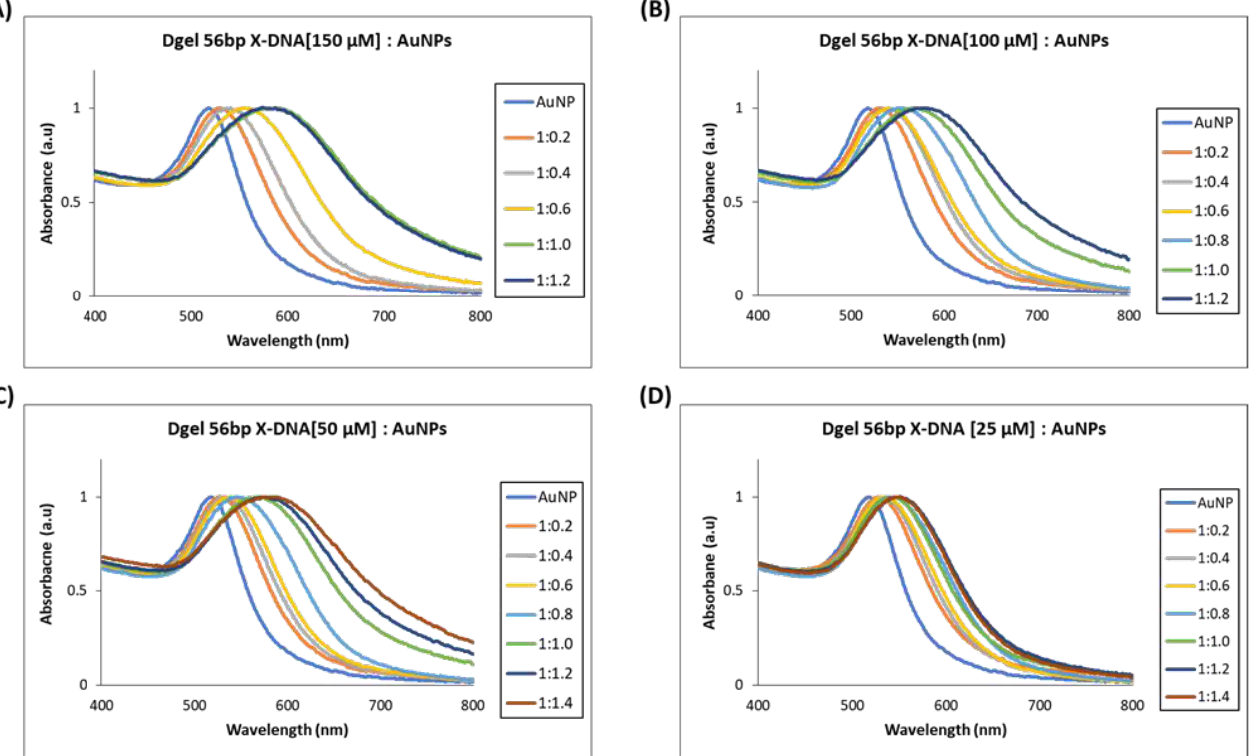
Figure 4. UV visible spectrum analysis of Dgel fabrication with the variations in the concentration of 56 bp X-DNAs, whereas AuNPs concentration and ratios, were constant, respectively. ( A ) Dgel (56 bp X-DNA [150 µM]: AuNPs) ( B ) Dgel (56 bp X-DNA [100 µM]: AuNPs) ( C ) Dgel (56 bp X-DNA [50 µM]: AuNPs) ( D ) Dgel (56 bp X-DNA [25 µM] AuNPs).